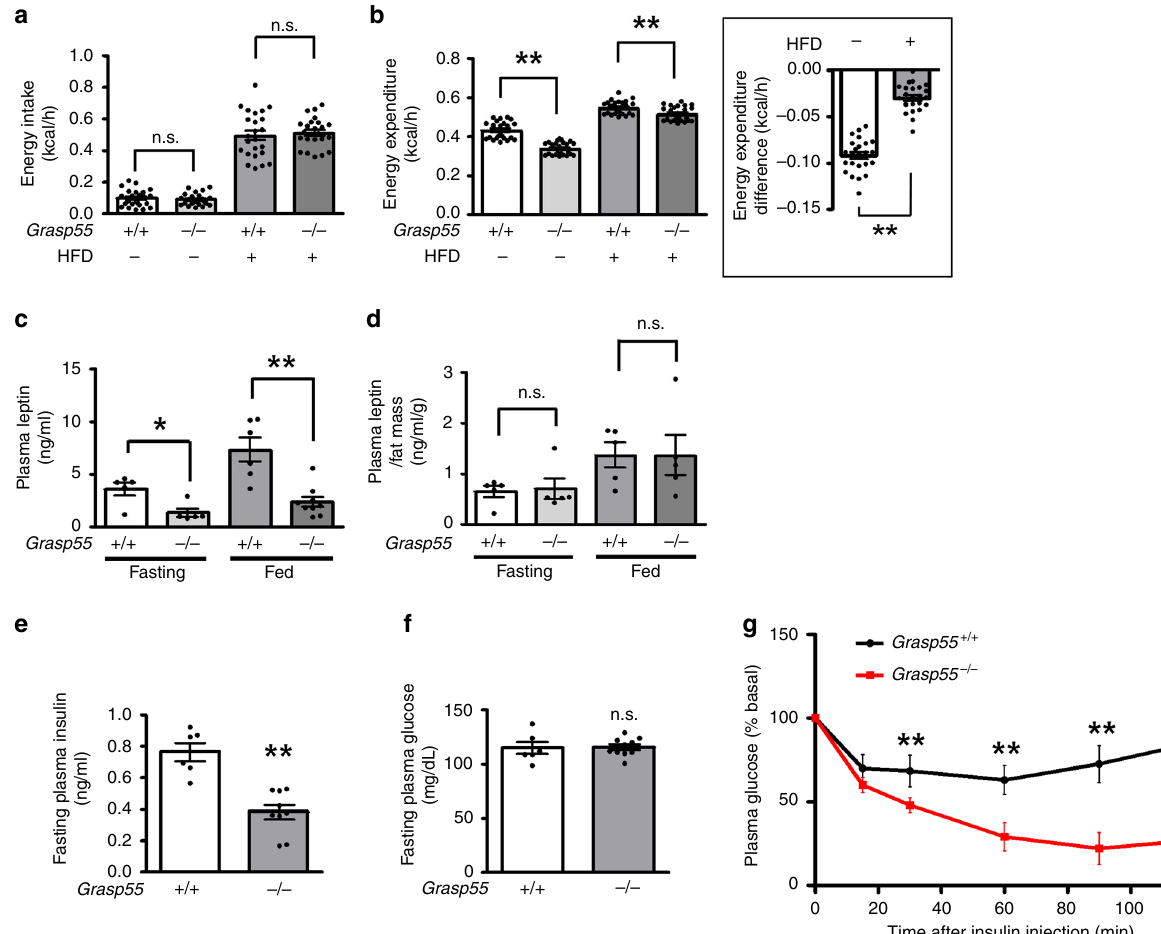
Fig. 2 Metabolic pro fi les of Grasp55 − / − mice. a , b Analyses of energy intake ( a ) and energy expenditure ( b ) were conducted in 12-week-old Grasp55 + / + and Grasp55 − / − mice fed normal diet (ND) or high-fat diet (HFD). Energy expenditure differences between Grasp55 + / + and Grasp55 − / − mice are plotted in ( b inset). Data are shown as average values from a 2-day observation ( n = 6). c , d Plasma leptin levels of 12-week-old Grasp55 + / + and Grasp55 − / − mice that were fasted for 16 h and fed ND ( n = 6). Plasma leptin levels normalized to body fat mass of mice are presented in d ( n = 6). e , f Fasting plasma levels of insulin ( e ) and glucose ( f ) were measured in 12-week-old Grasp55 + / + and Grasp55 − / − mice fasted for 16 h ( n = 6). g An insulin tolerance test was performed in mice fasted for 4 h. The relative ratios of blood glucose levels to basal glucose levels were determined at the indicated time points following intraperitoneal administration of human insulin (0.75 U kg − 1 body weight) in 12-week-old Grasp55 + / + and Grasp55 − / − mice ( n = 6). Data are shown as mean ± SEM. n.s.: not signi fi cant, * p < 0.05, ** p < 0.01. All p values were calculated by unpaired two-tailed Student ’ s t tests. Source data are provided as a Source Data fi